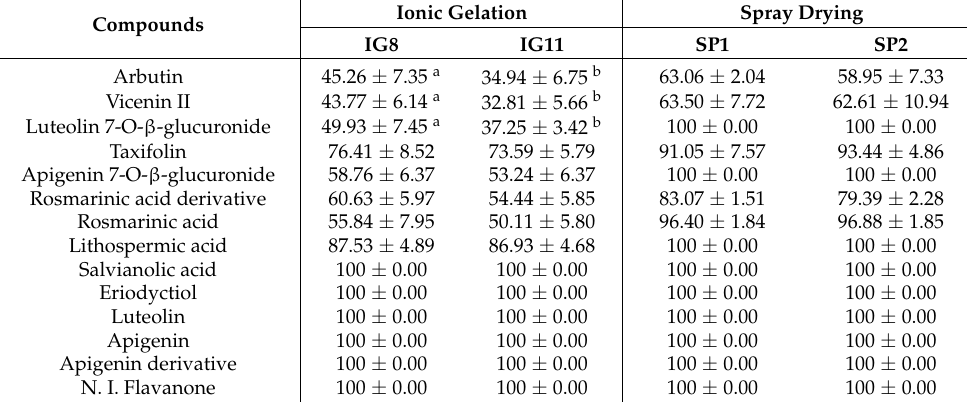
Table 4. Encapsulation efficiency (%) of different phenolic compounds in formulations IG8, IG11, SP1, and SP2 (mean ± SD, n =